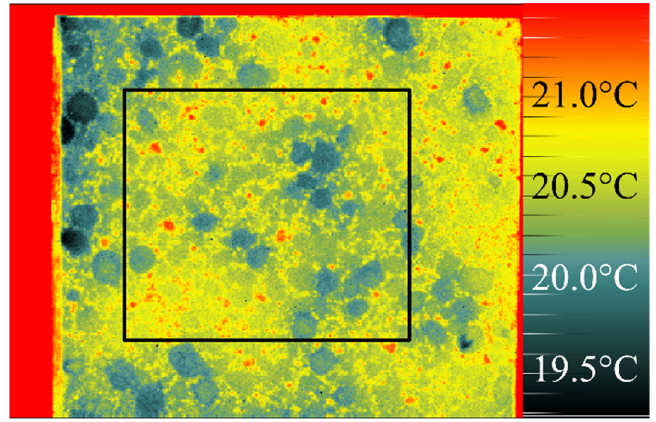
Figure 15. Thermogram of the wet (5.4% water content) type 1 sample before pulse heating. The black rectangle indicates the region used for extraction of the transient.